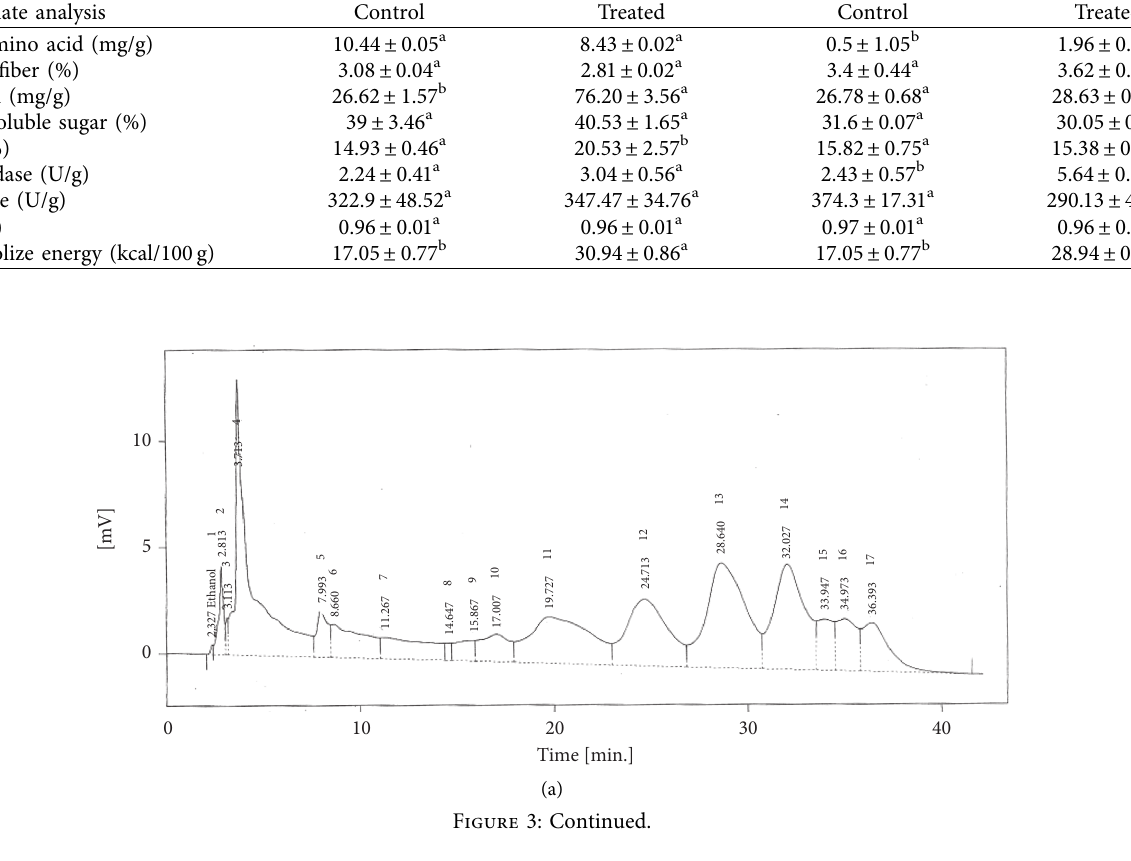
Table 2: Biochemical attributes of zinc sulfate treatment on seed priming of M. charantia for nutritive analysis in fruit and peel. Fruit